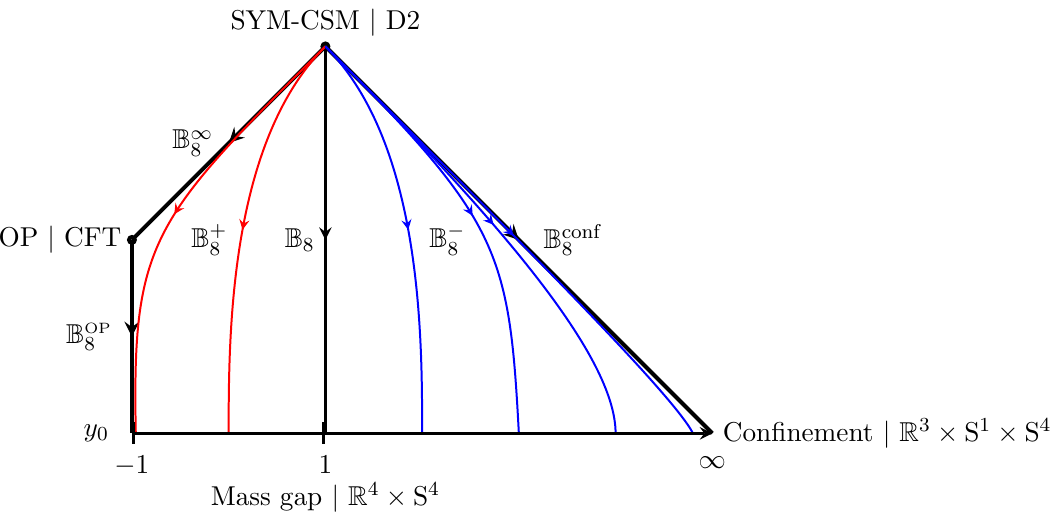
Figure 1 . Pictorial representation of the di(cid:11)erent solutions described in the main text. We indicate the geometry, together with the dual interpretation, as a function of the parameter y 0 . The arrows indicate the direction of the RG (cid:13)ow from UV to IR. Figure taken from